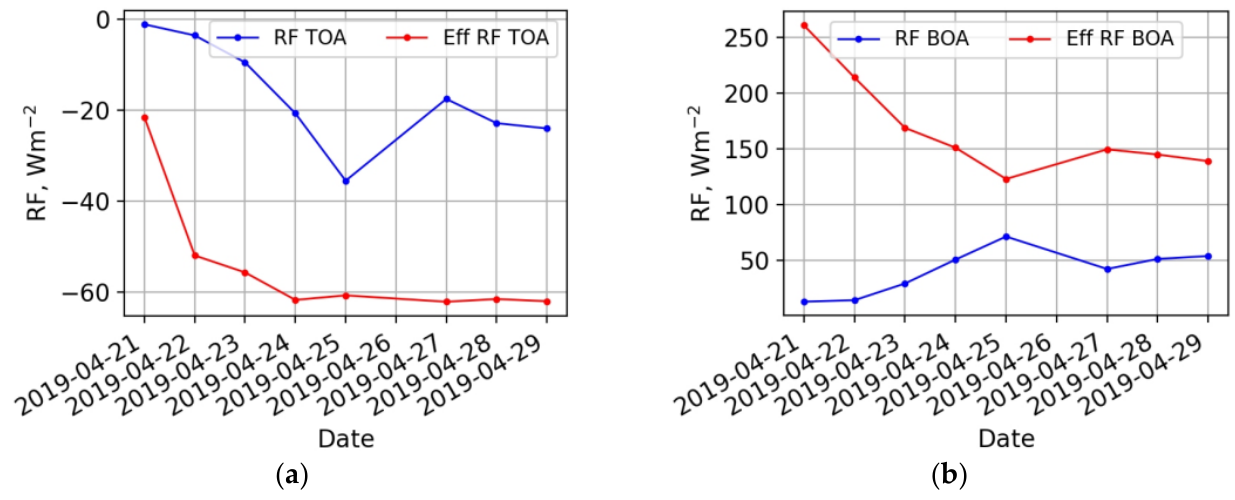
Figure 12. Radiative forcing (RF) and effective radiative forcing (Eff RF) at ( a ) the top of atmosphere (TOA), ( b ) bottom of atmosphere (BOA), and daily averaged RF data in the 21–29 April period. AERONET retrieval data level 2.0 for ( b